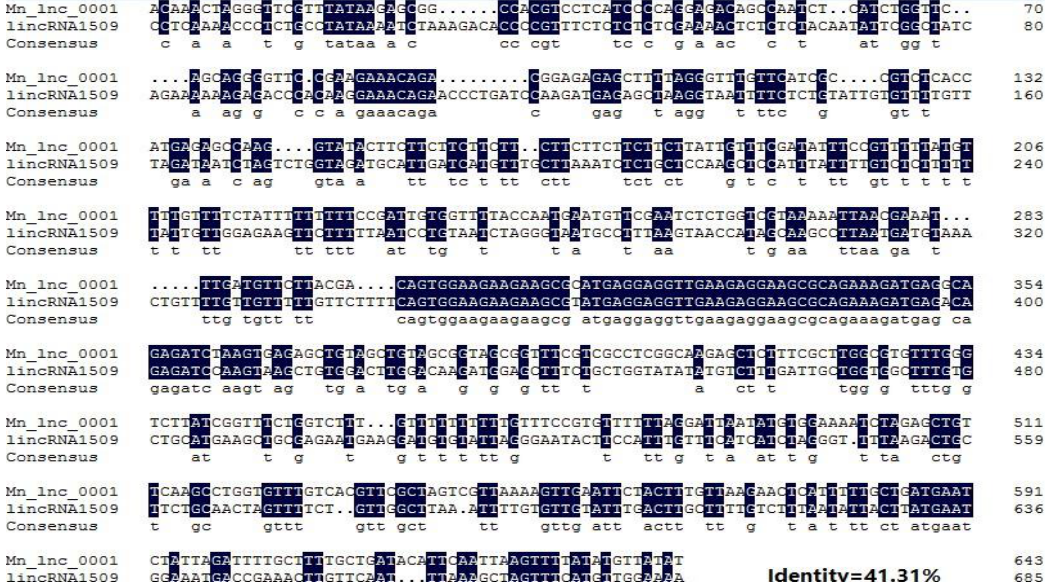
Figure 6. Comparison of expression levels between known coding genes and lncRNAs. ( A ) represents the density of expression of known-coding genes N = 26965, Bandwidth = 0.3673; and ( B ) represents the lncRNAs, N = 1005, Bandwidth = 0.5891.